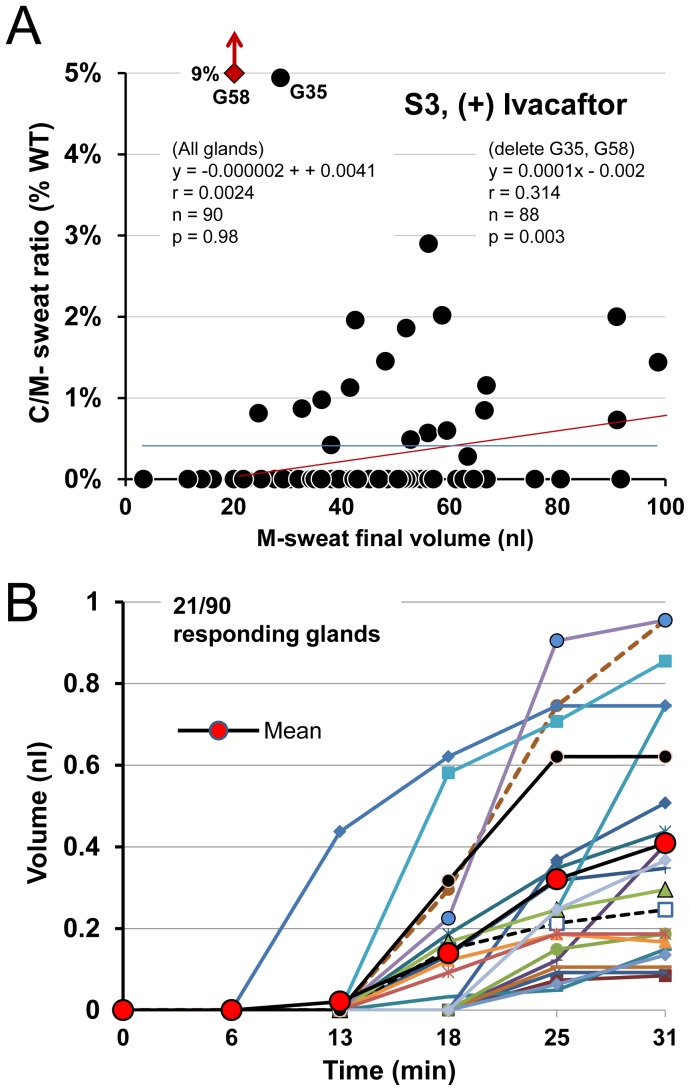
C-sweat secretion (+) ivacaftor in CF subject 3: female, F508del/G551D.S4 was tested only once, (+) ivacaftor. (A) Gland-by-gland correlations of M- and C-sweating using the same conventions as above. M-sweat was measured for 90 glands of which 21 also produced C-sweat with C/M ratios of 0.3% to 5% of the mean WT ratio. (B) Volume vs. time plots for C-sweating of each responding gland. β-adrenergic cocktail injected at time 0, and no observations were made during the first 3 min when atropine was taking effect and when the site was rinsed and dried before reapplying oil. Note slow time course of response.